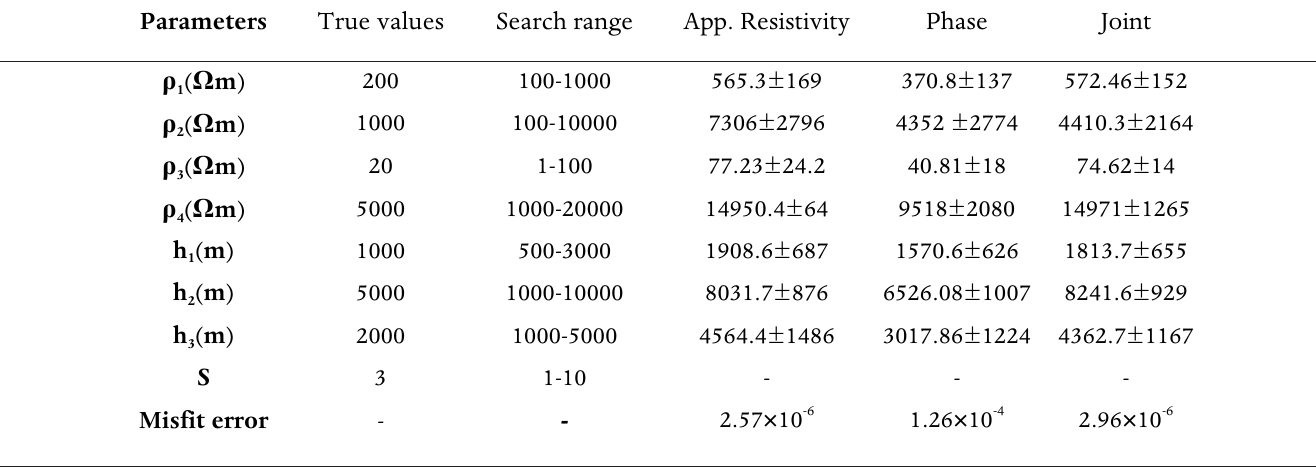
Table 3. Model 2: inversion results without optimization of static